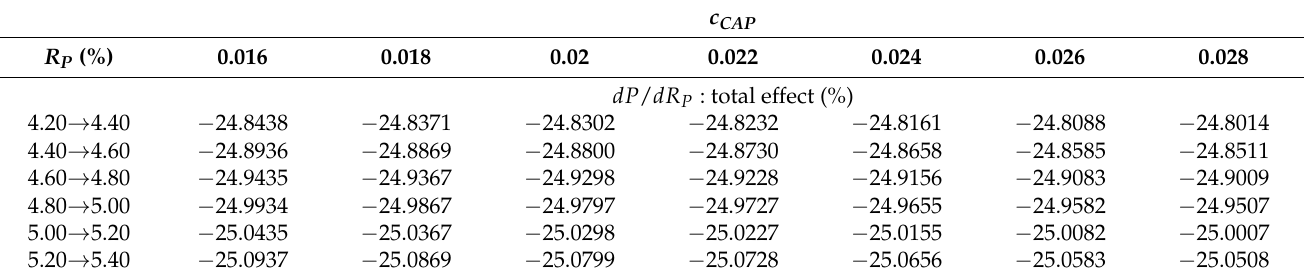
Table 7. Responsiveness of the policyholder protection to the policy loan rate at various levels of c CAP . c